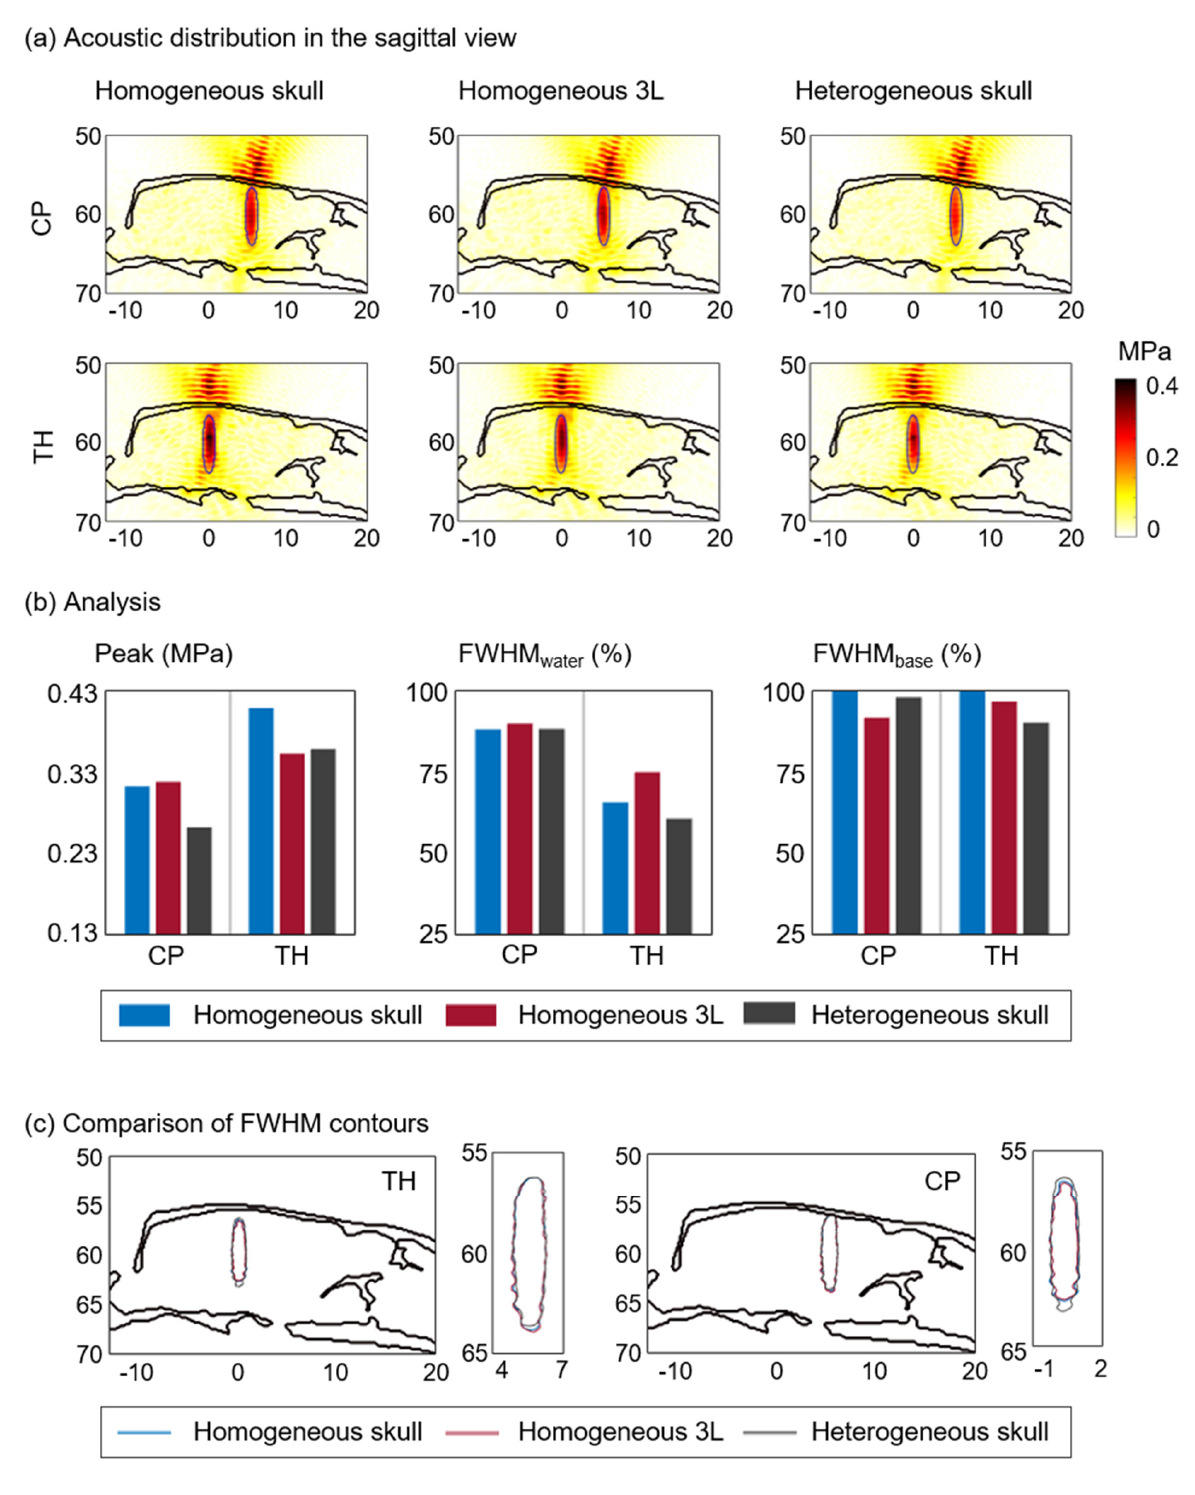
Figure 3. ( a ) Simulated acoustic pressure distributions and ( b ) analysis of the distributions corresponding to the homogeneous skull, homogeneous 3L, and heterogeneous skull models at 1.1 MHz. The intracranial maximum pressure, FWHM water , and FWHM base are compared. ( c ) FWHM contours of the homogeneous skull (blue line), homogeneous 3L (red line), and heterogeneous skull (black line) models.